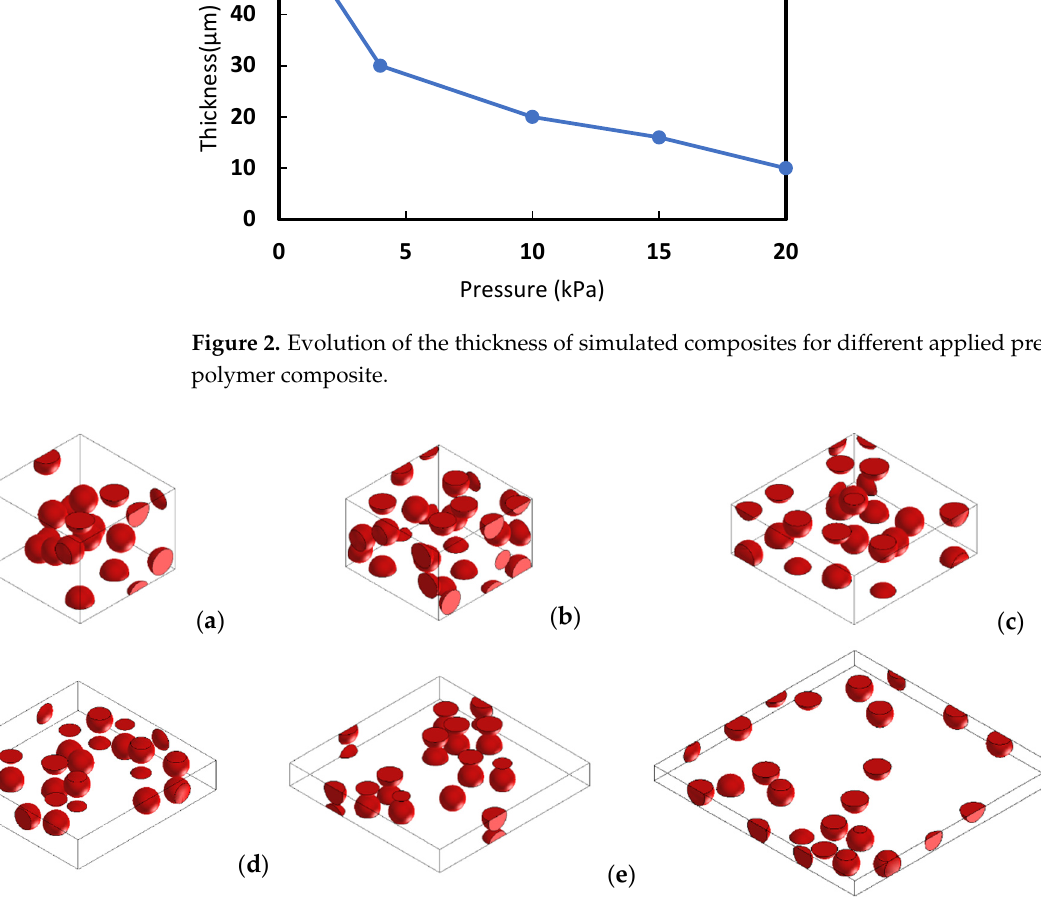
Figure 3. Simulated RVEs for 9.5. vol% Cu-PU composite for several applied pressures on the polymer composite. ( a ) 1 kPa, ( b ) 2 kPa, ( c ) 4 kPa, ( d ) 10 kPa, ( e ) 15 kPa and ( f ) 20 kPa.